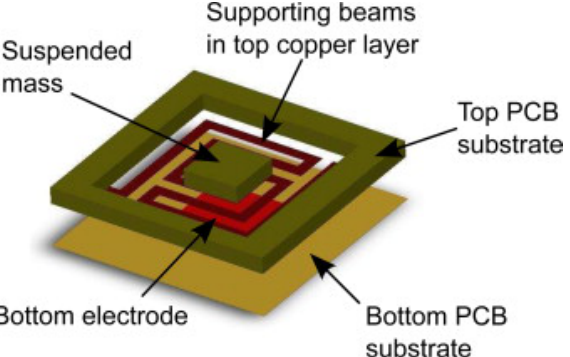
Figure 9. Structure of capacitive PCB-based accelerometer. The beams were fabricated using the copper layer, and the proof mass was defined with the FR4 substrate (reprinted from [124], copyright (2011), with permission from